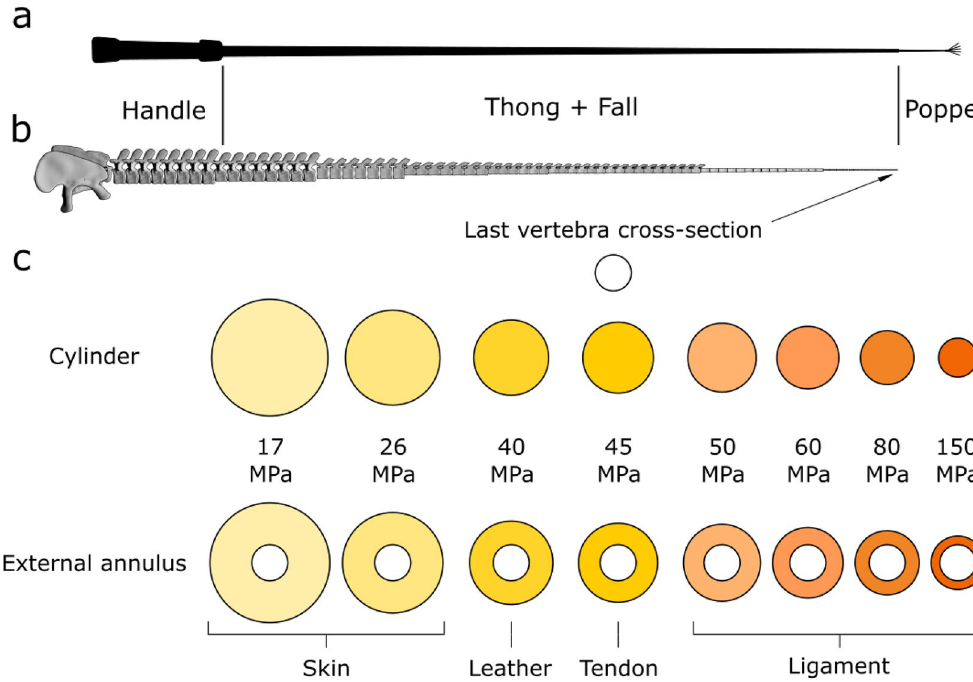
Figure 3. Anatomy of a bullwhip compared to the model and graphical representation of the soft tissue surface needed to bear the supersonic stresses compared to the hypothesized size of the final vertebral element. ( a ) Drawing of a bullwhip. ( b ) Model of sauropod tail in lateral view. ( c ) Graphical representation of the cross- section of the last vertebral element, compared to the cross-sections of soft tissues needed to bear the supersonic stresses. The first row represents the size of the soft tissue as cylindrical structure. The second row represents the size of soft tissues as annulus external to the hypothesized vertebral